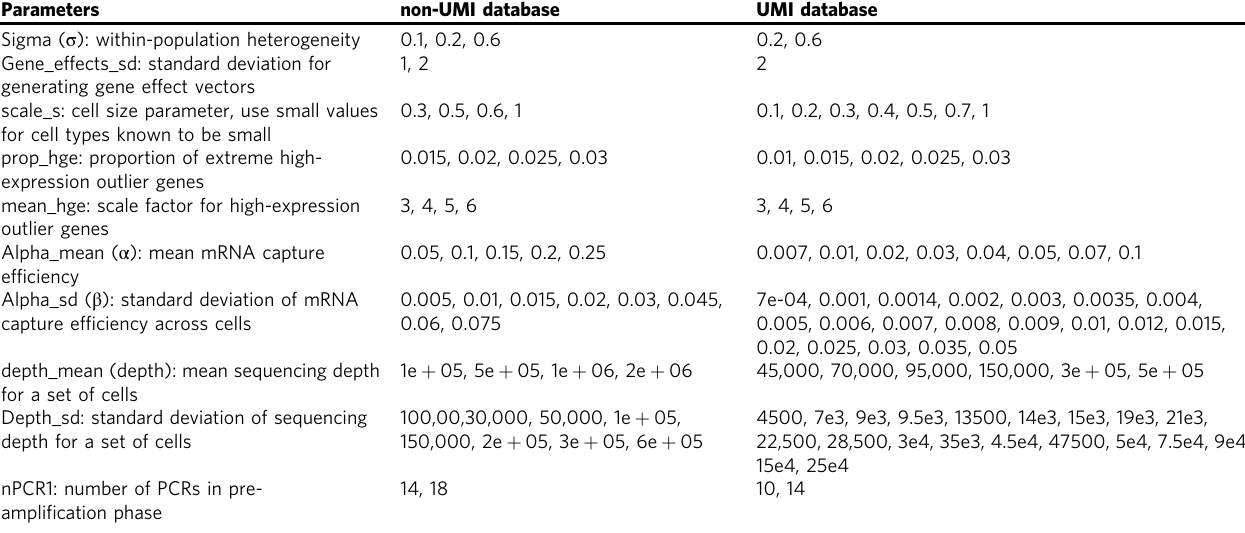
Table 2 Parameters and their ranges for simulating the UMI and nonUMI databases